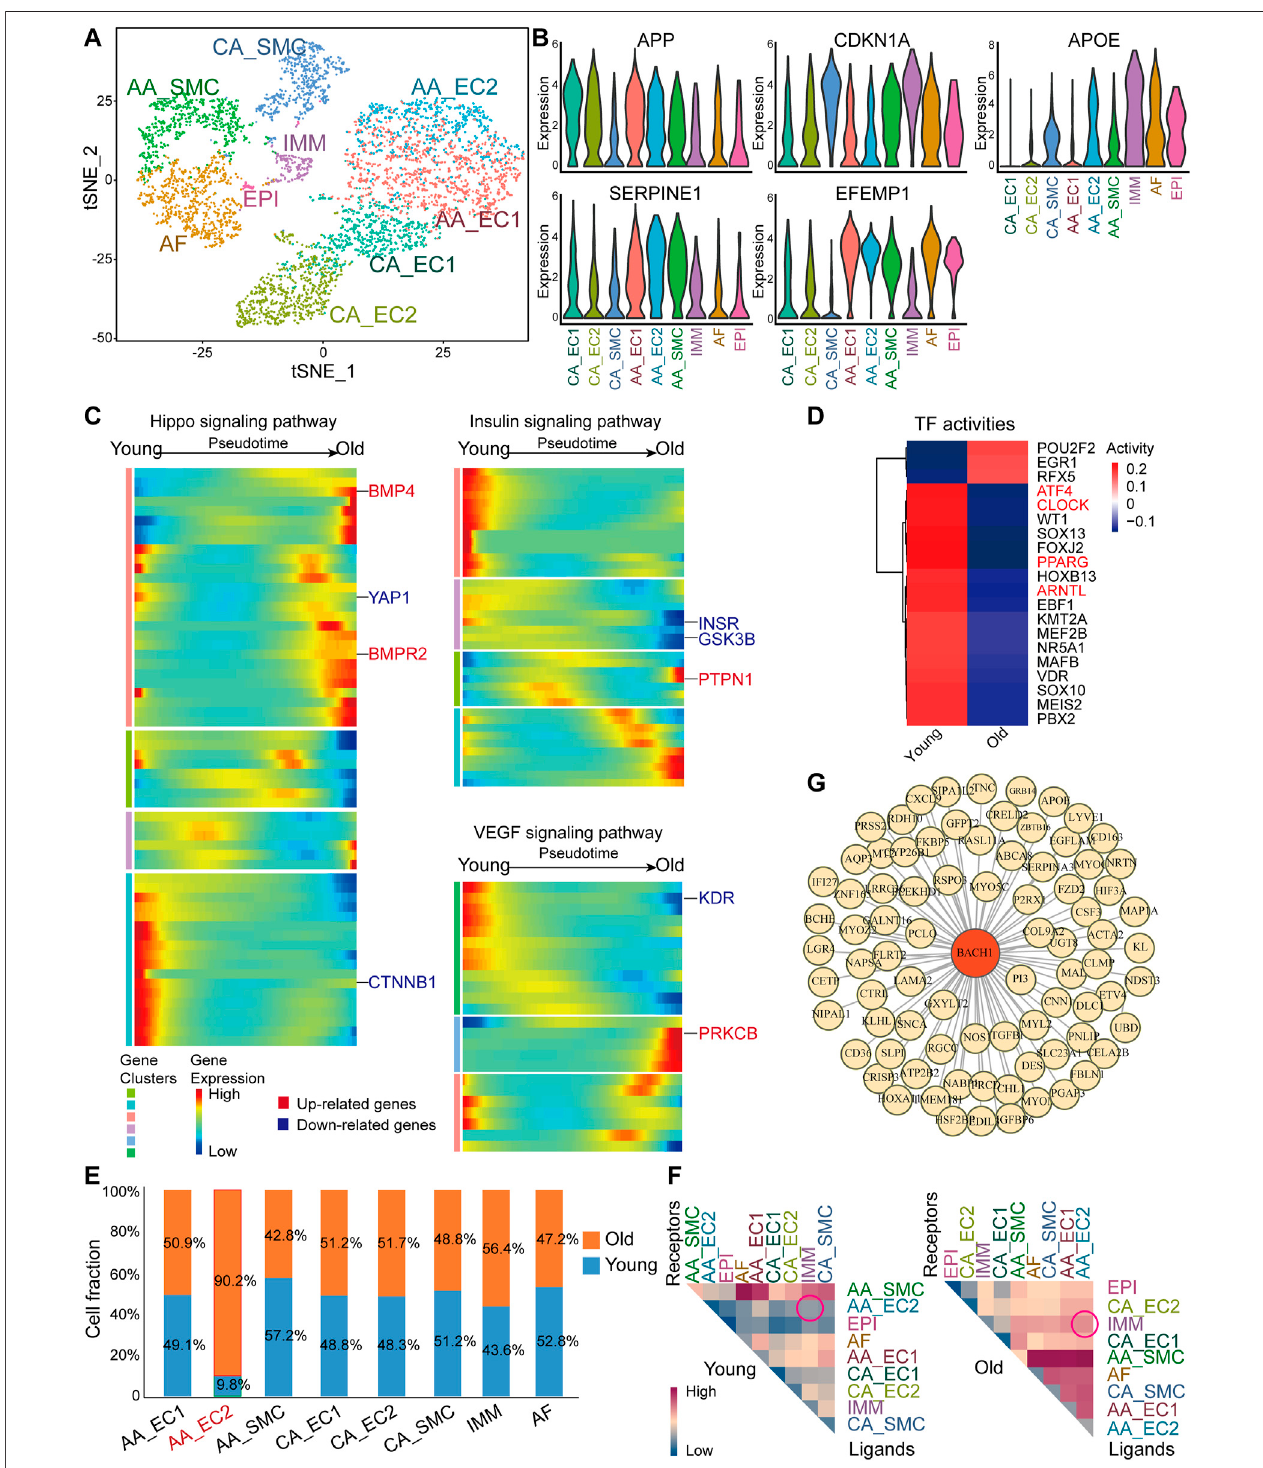
FIGURE 1 | Single-cell RNA sequencingscRNA-seq) analysis of aortas and coronary arteries from young and old monkeys. (A) A t-SNE diagram of the global cell population (5,291 cells). The plot is color-coded by cell clusters identi fi ed by unsupervised analysis. (B) Violin plot of normalized expression of aging-related genes amyloid beta precursor protein ( APP ), CDKN1A , apolipoprotein ( APOE ), serpin family E member 1 ( SERPINE1 ), and EGF-containing fi bulin extracellular matrix protein 1 ( EFEMP1 ). (C) Pseudotime heatmap showing relative expression of signaling pathway-related genes from the state of young to old in endothelial cells (ECs) from the coronary vasculature (CA_ECs). (D) Heatmap of selected TF activities inferred by DoRothEA between young and old monkeys. Red color genes are potential